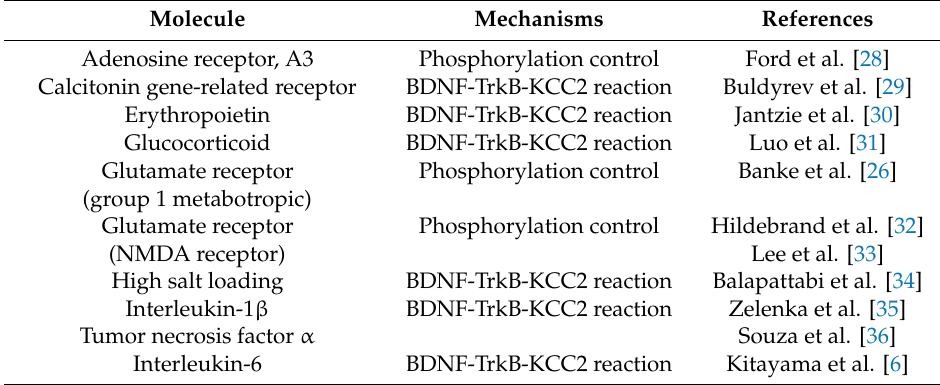
Table 1. Molecules that a ff ect the K + -Cl − -cotransporter-2 (KCC2)